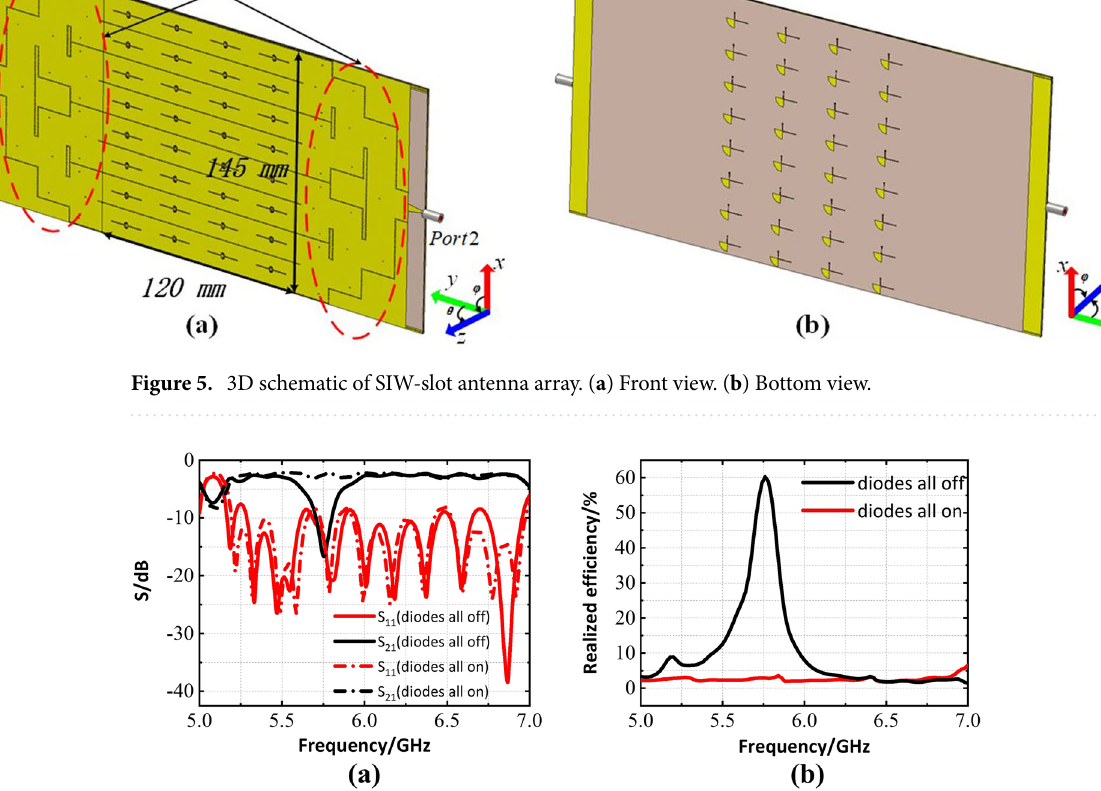
Figure 6. Simulated performance of the designed SIW-slot antenna array (8 by 4 slot elements) ( a ) Scattering parameters. ( b ) Realized radiation